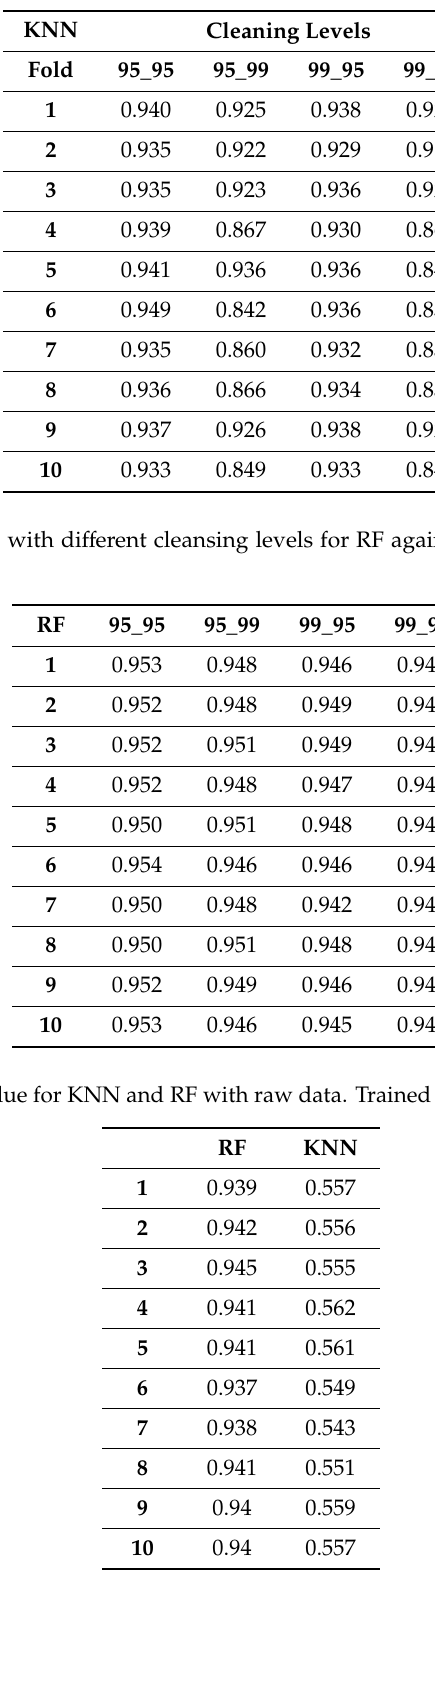
Table 8. F-measure value with di ff erent cleansing levels for KNN against the corresponding cleaned test set.